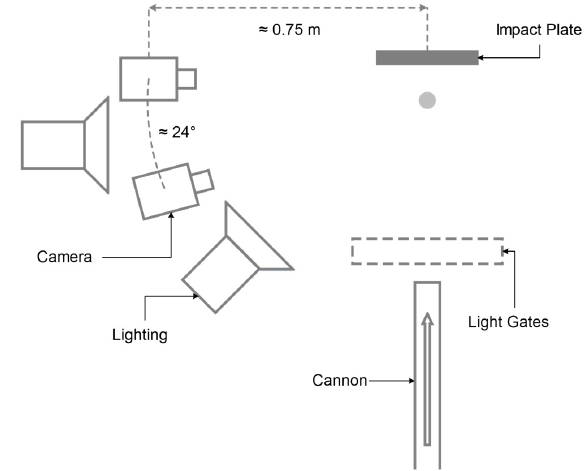
Figure 1. Plan view of lab set ‐ up.